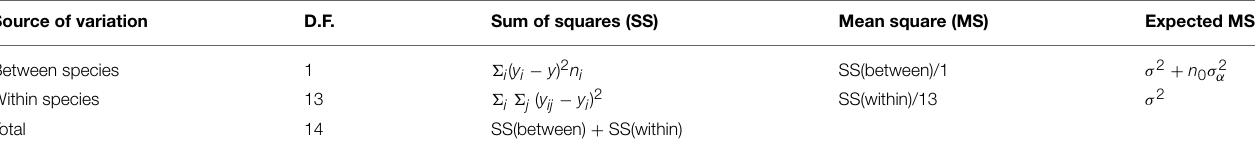
TABLE 1 | Application of the ANOVA method for H3K4me3 peaks in humans and chimps. Source of